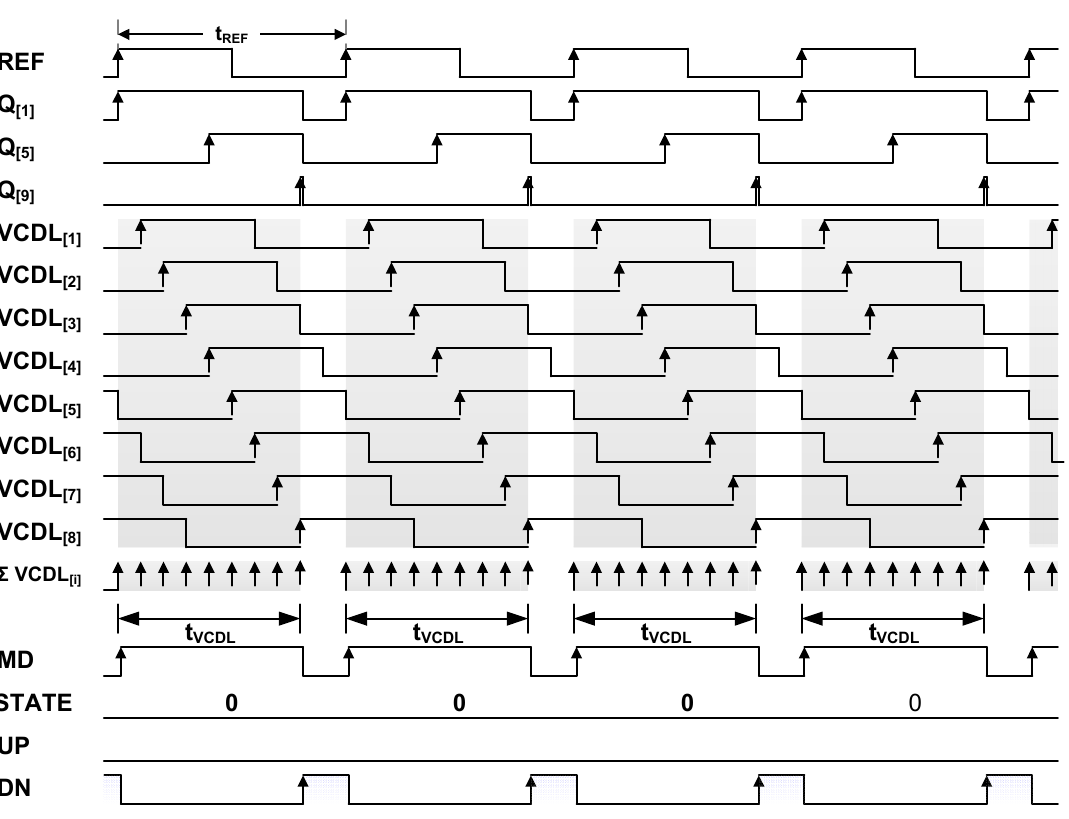
Figure 5. Timing diagram for the PD-MDV operation under the condition t VCDL < t REF . 2.2. Case 2: PD-MDV Operation with Fixed Middle V CTRL for t REF < t VCDL ≤ 2·t REF Figure 6 is a timing diagram for t REF < t VCDL ≤ 2· t REF . Σ VCDL [i] , that is, the pulse width